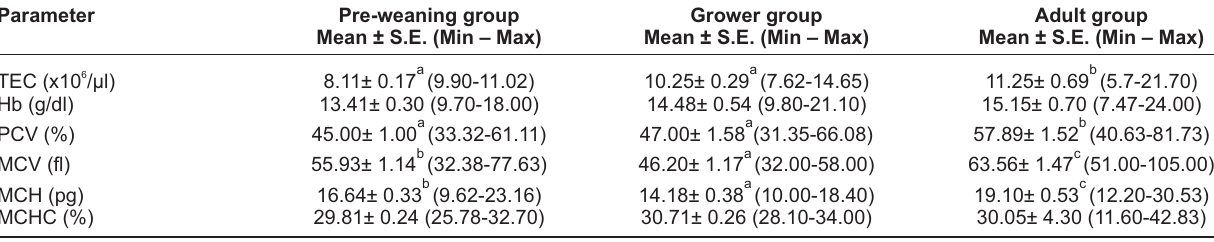
Table-1: Effect of age on erythrocyte picture of Zovawk pigs Parameter Pre-weaning group Grower group